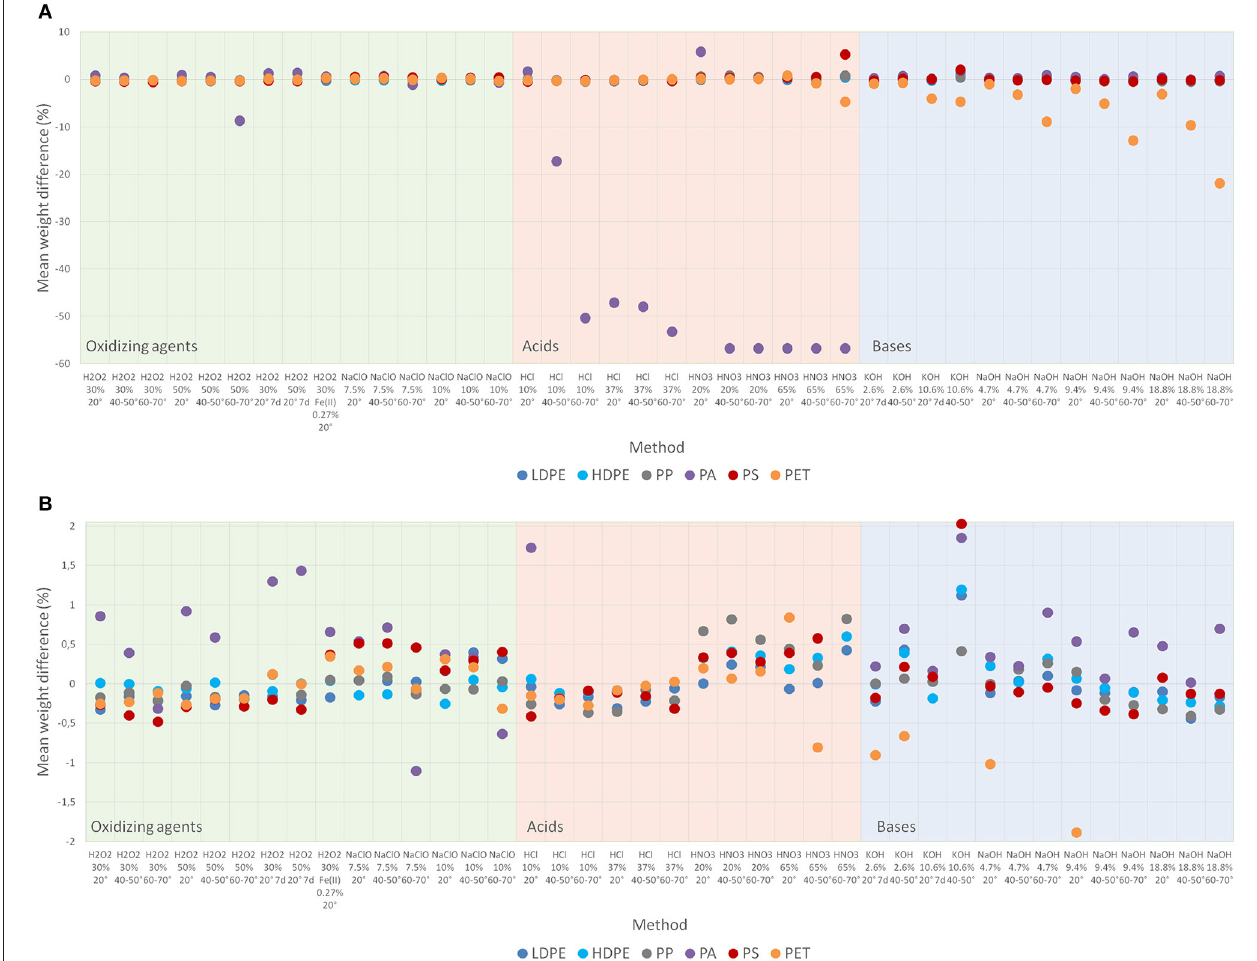
FIGURE 1 | (A) Mean resistance of synthetic polymer particles against applied digestion protocols (expressed as mean difference in weight (%) of size standardized particles, full scale). (B) Mean resistance of synthetic polymer particles against applied digestion protocols (expressed as mean difference in weight (%) of size standardized particles, focused scale to values of ± 2% difference in